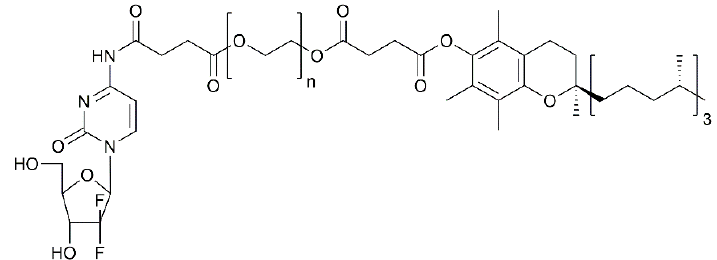
Figure 3. Chemical structure of tocopherol poly(ethylene glycol) succinate 1000-gemcitabine polymer drug conjugate.